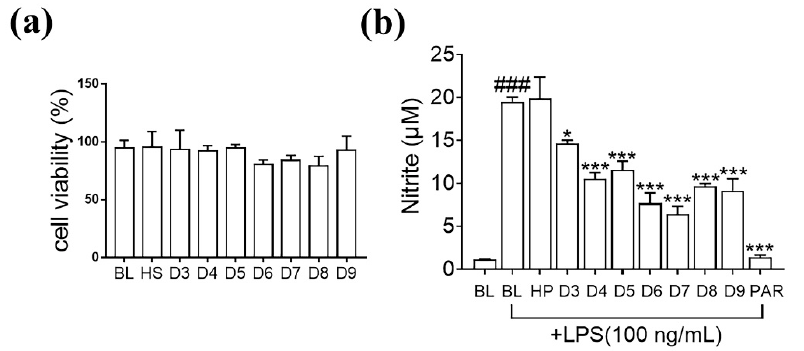
Figure 1. Effects of HS and FHS on cytotoxicity and nitrite production in LPS-stimulated N9 microglia. ( a ) Cell viability was examined by MTT assay. Cells were cultured with HS and different days of FHS (1:50, v / v ) for 24 h ( n = 3). ( b ) Nitrite from the supernatants was detected through Griess assay. Cells were incubated with HS and different fermentation days of FHS (1:50, v / v ) for 1 h and then stimulated by LPS for 24 h ( n = 3). BL, medium without the addition of extracts; HS, unfermented hemp seed-containing medium supernatant; D3-D9, different fermentation day’s supernatant of fermented hemp seed. ### p < 0.001 vs the control group; * p < 0.05, *** p < 0.001 vs. the LPS-treated group.